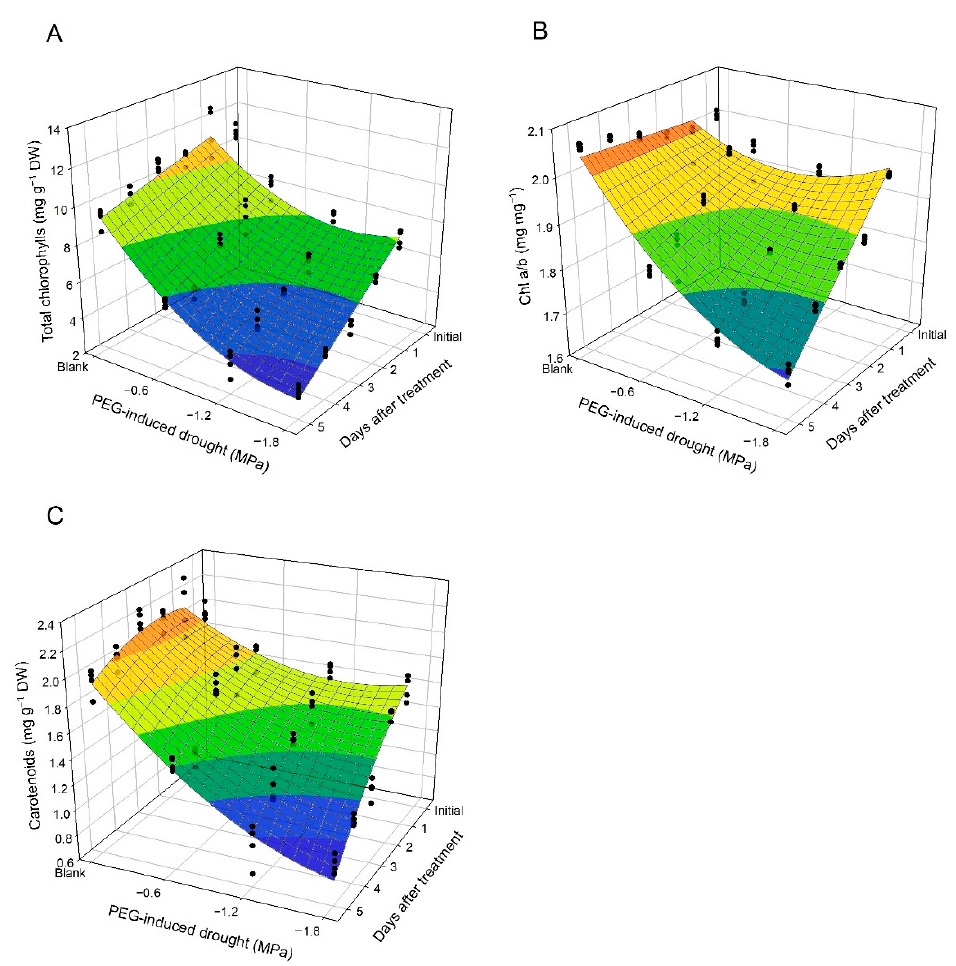
Figure 3. Scatter plots and regression surfaces of total chlorophyll ( A ), Chl a / b ratio ( B ), and carotenoids ( C ) in tea leaf discs as affected by PEG-induced osmotic stress during a 5-day period.